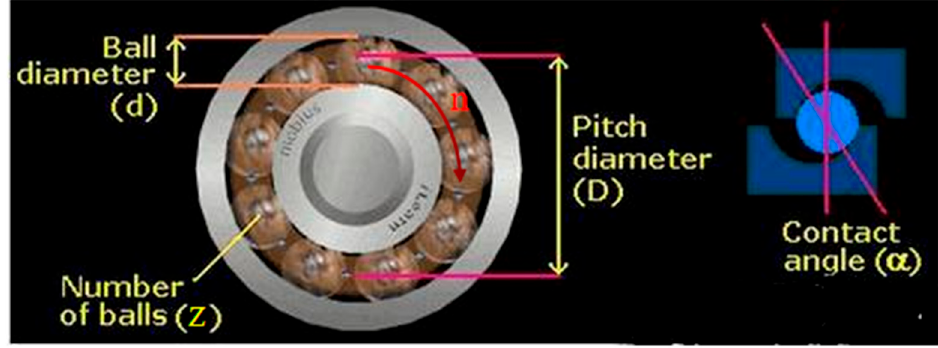
Figure 1. Schematic diagram of the geometric parameters of rolling